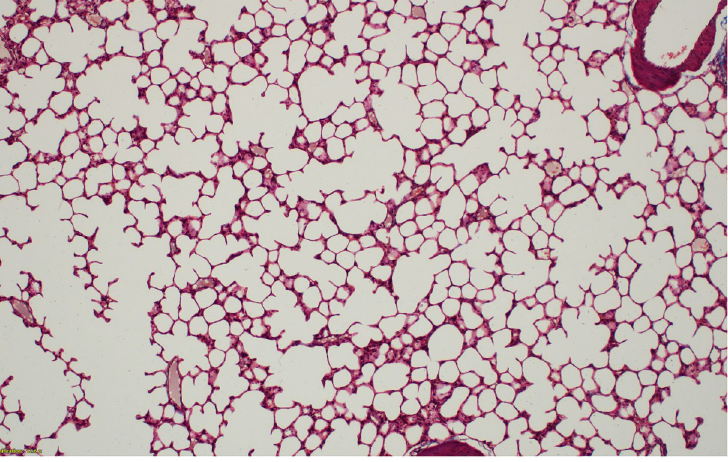
Fig 7. No fibrosis in control lungs at 8 weeks after normal saline instillation (Ashcroft score 0) (Masson’s trichrome (MT) stain, x100).